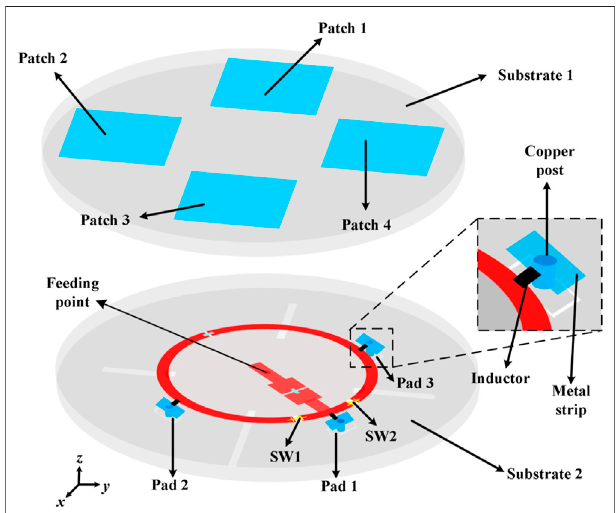
FIGURE 1 | Three-dimensional con fi guration of the proposed polarization recon fi gurable antenna.